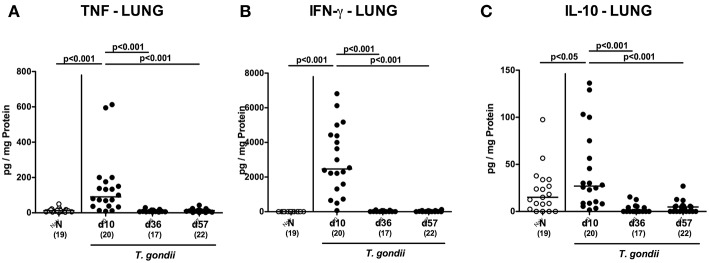
Pulmonal inflammatory mediator secretion over time following peroral low-dose T. gondii infection. Mice were perorally infected with one cyst of T. gondii on day 0 and surveyed at days (d) 10, 36, and 57 post-infection (p.i.; closed circles). Naive (N) mice served as uninfected controls (open circles). (A) TNF, (B) IFN-γ, and (C) IL-10 concentrations were measured in ex vivo biopsies taken from the lungs at respective time points. Medians (black bars), levels of significance (p-values) as determined by one-way ANOVA test followed by Tukey post-correction for multiple comparisons and numbers of analyzed mice (in parentheses) are indicated. Data were pooled from four independent experiments.